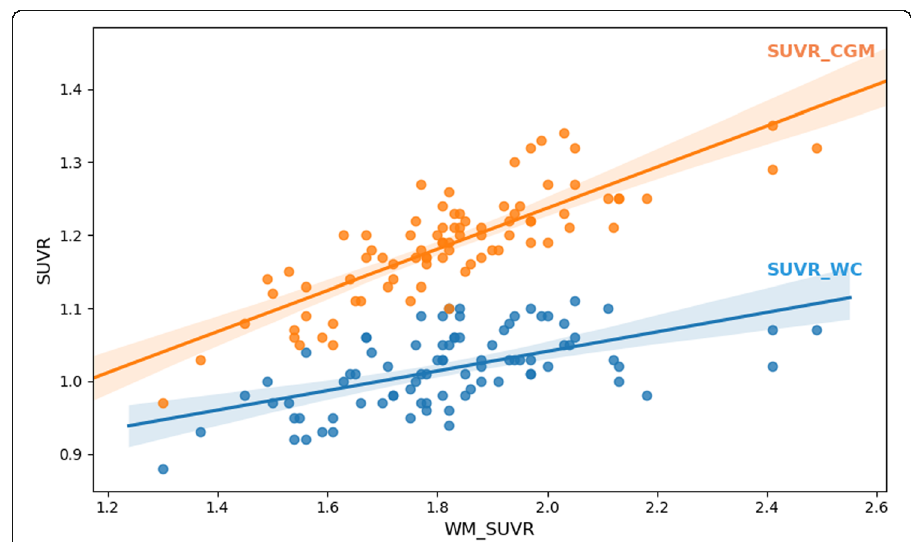
Fig. 3 Relation between WM-SUVR CGM and GM SUVRs. Orange dots (and orange line) are for the CGM as a reference region (SUVR CGM ), while the blue dots (and blue line) are for the WC as a reference region (SUVR WC ) each of the patients, WM was modified by multiplying the WM by a constant to pro- values of 1.4, 1.6, 1.8, 2.0, 2.2, 2.4, 2.6, 2.8, duce maps with theoretical WM-SUVR CGM